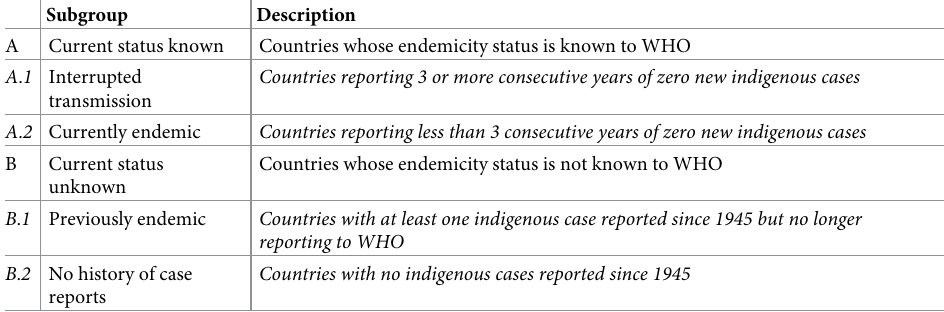
Table 1. Grouping of countries according to yaws endemicity status in